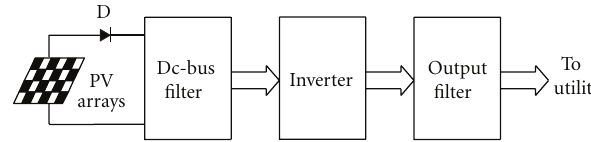
Figure 3: A block diagram to represent a single-stage grid- connection PV